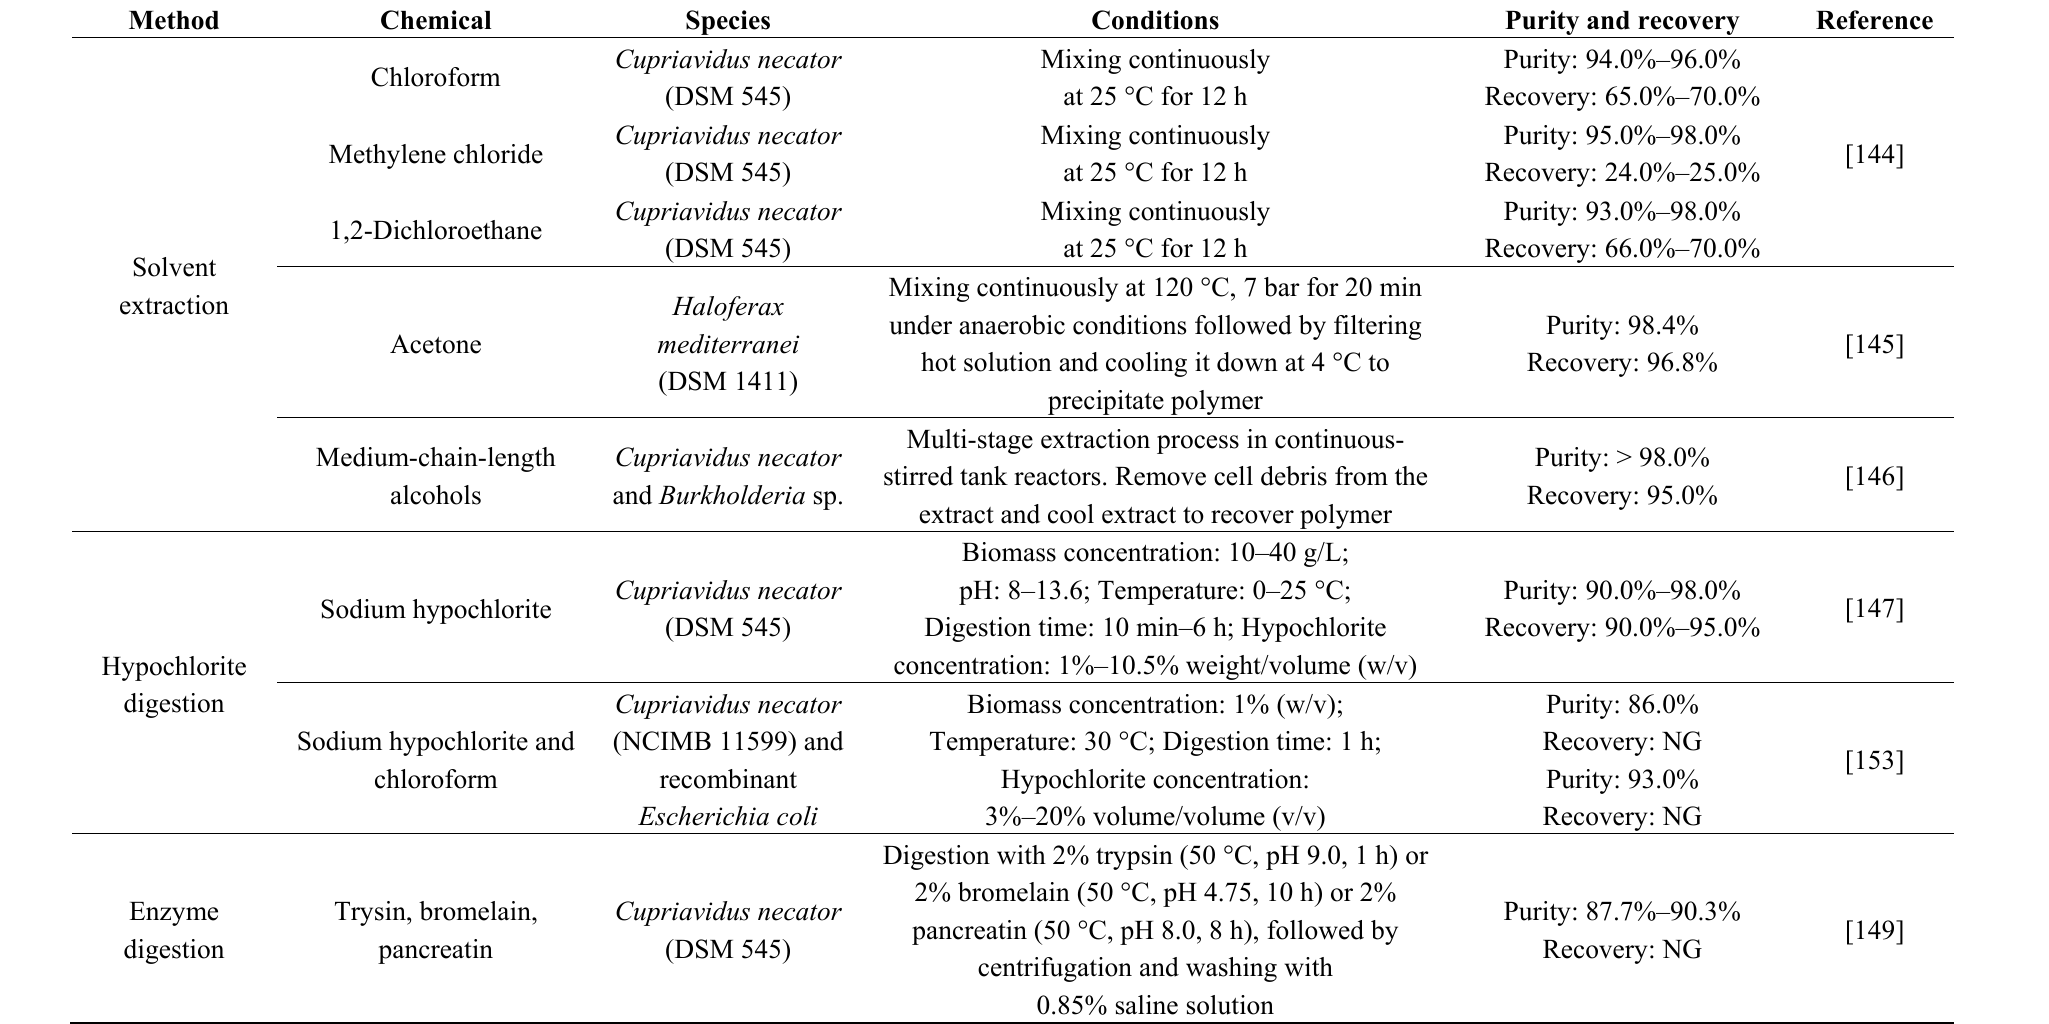
Table 4. Poly(3-hydroxybutyrate) (P3HB) recovery methods (modified from